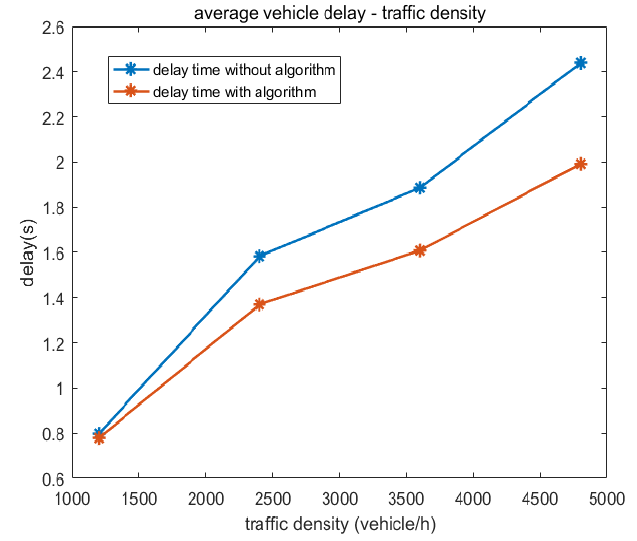
Figure 9. Comparison of vehicle’s delay with coordination strategy and without coordination strategy in different traffic densities.